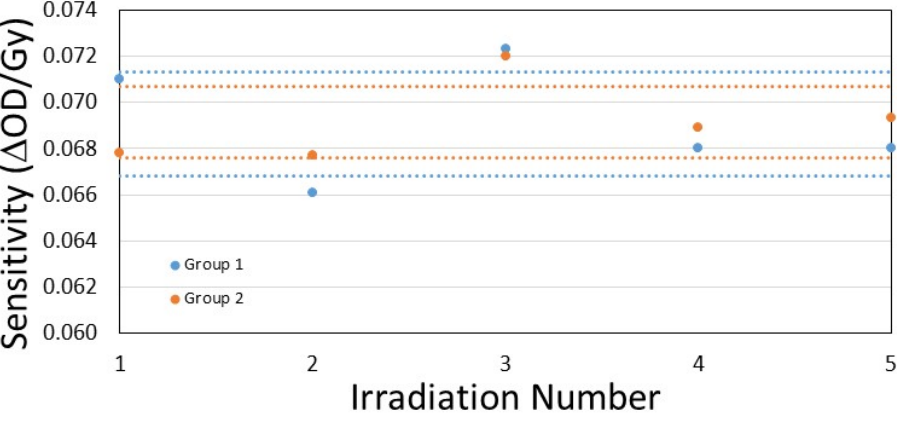
Figure 10. The measured sensitivity for each of the five irradiations of both Formulation 3 groups is plotted above. The dotted lines represent the one population standard deviation bounds from the average for each group.